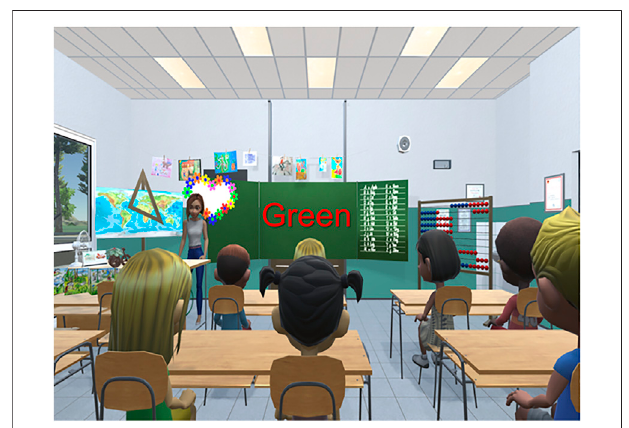
FIGURE 4 | Virtual Classroom Stroop